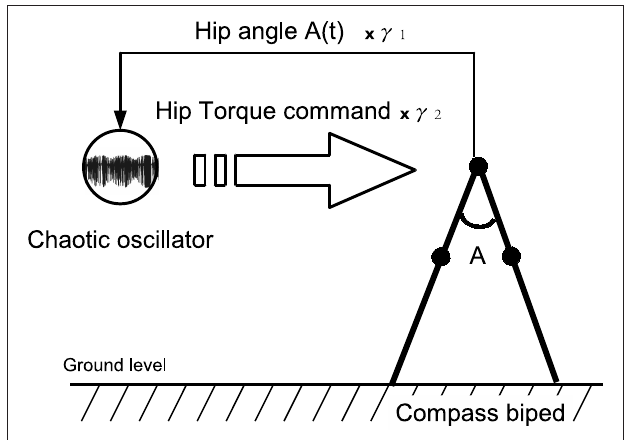
FIGURE 4 | Control architecture for the compass biped walker coupled to one chaotic system. We hypothetize that for specifi c coupling values γ we will have the chaotic system matching the phase of the walker dynamics.